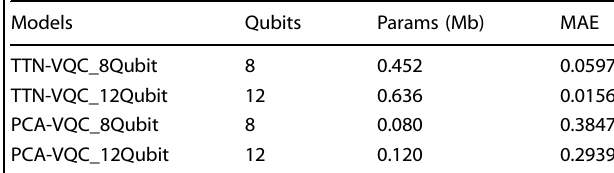
Table 2. Empirical results of TTN-VQC and PCA-VQC models on the test dataset.